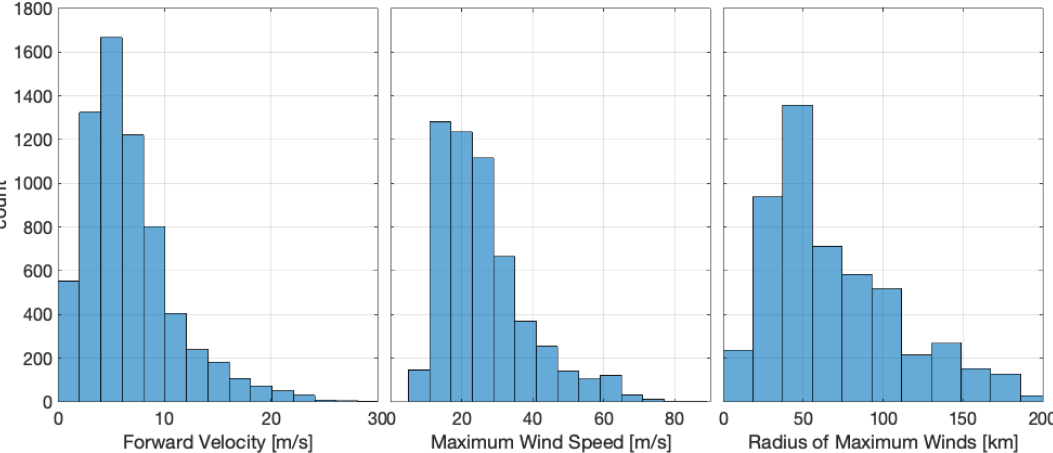
Figure 1. Histograms of ( left ) forward velocity, ( center ) maximum sustained wind speed, and ( right ) radius of maxi- mum winds.